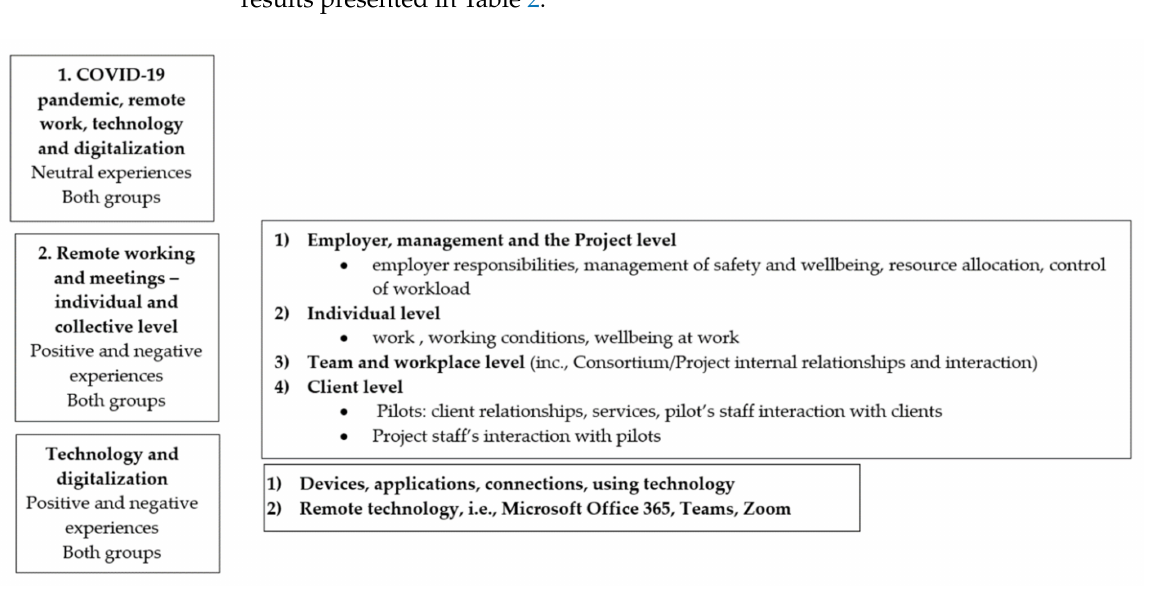
Figure 2. The main results in the thematic